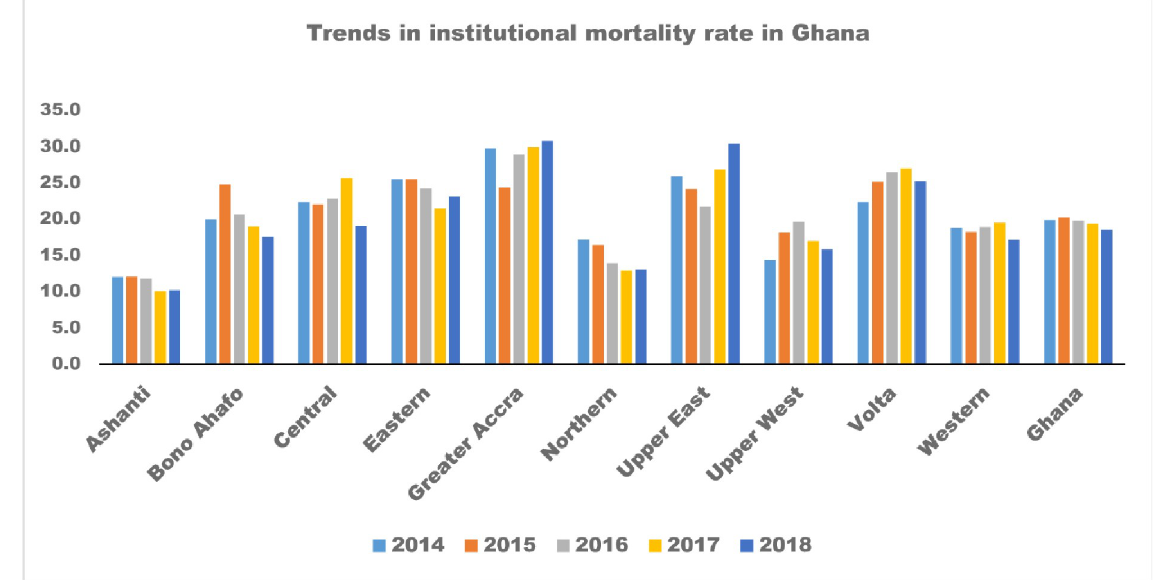
Fig 1. Trends in Institutional mortality rate in Ghana, 2014 and 2018, by regions. Source: Computed by authors based on Ghana Health Service’s DHIMS2, 2020.